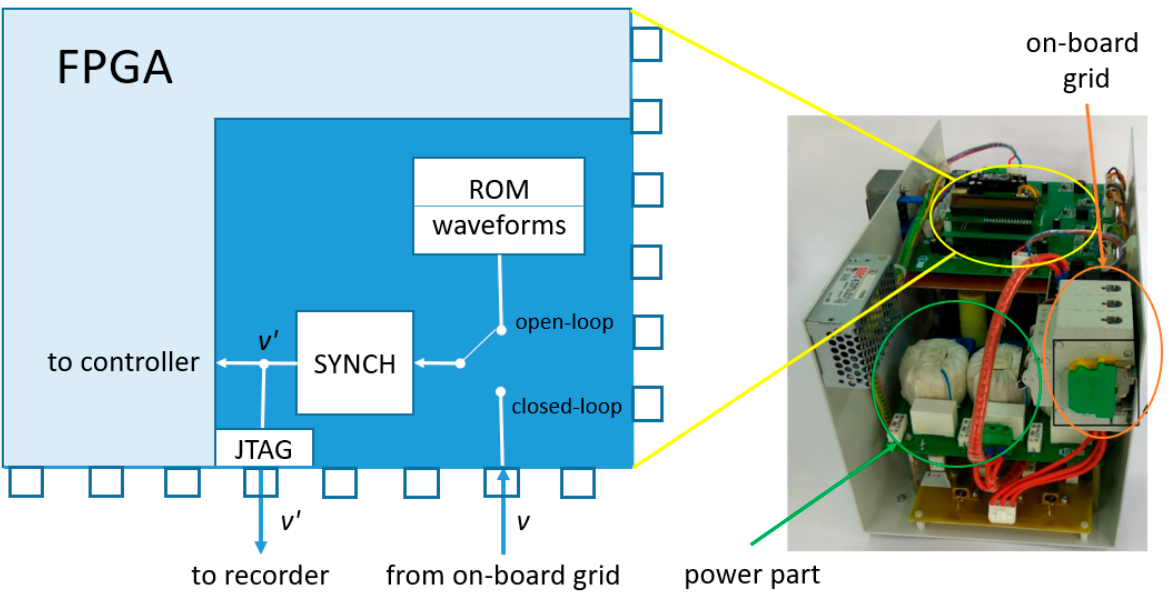
Figure 6. Hardware setup with diagram illustrating paths for open-loop and closed-loop tests of the synchronization system.